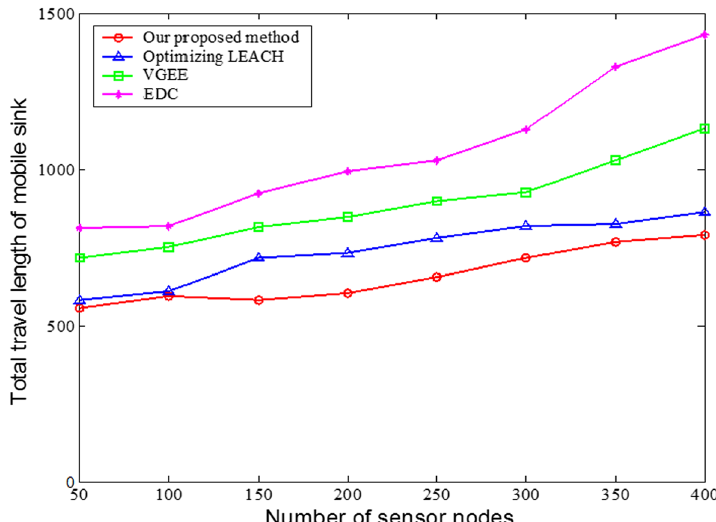
Fig. 6 Comparison of total length of mobile sink’s